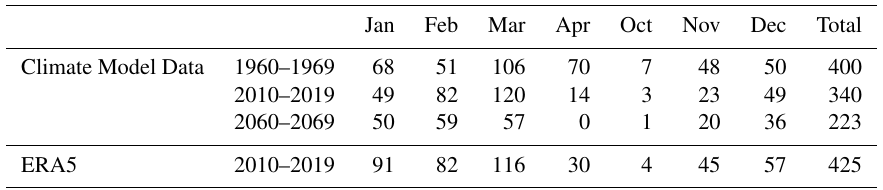
Figure 7. The ten-year average of the total annual (a) driving rain and (b) solar radiation incident on vertical surfaces facing towards the cardinal and intermediate orientations under the examined climate excitations. Table 3. Number of freeze-thaw events with freezing occurring at air temperatures below 0 ◦ C and thawing at air temperatures above 0 ◦ C for each ten-year